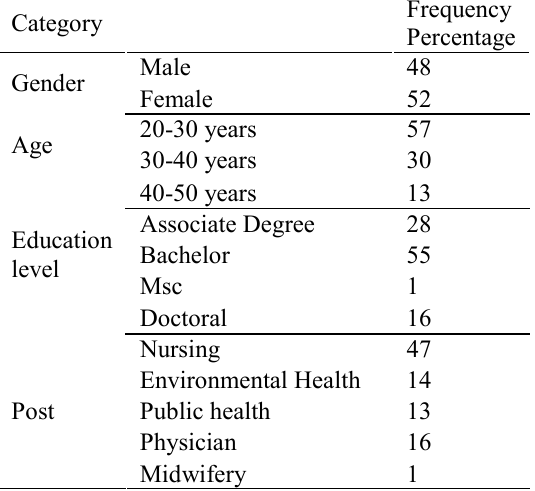
Table 1. Participant demographic characteristics